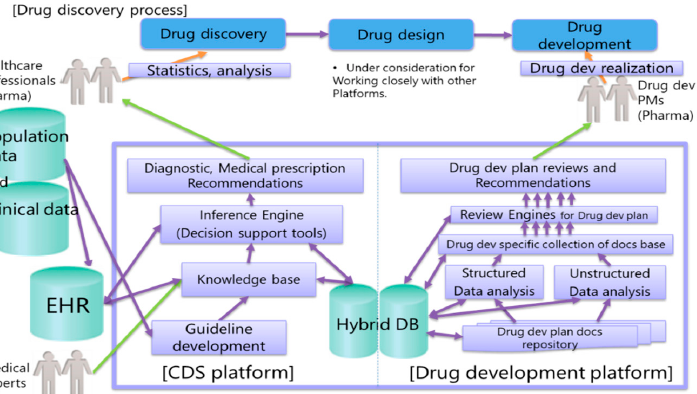
Figure 10. Reference architecture for digital platforms related to the drug discovery and develop- ment process.